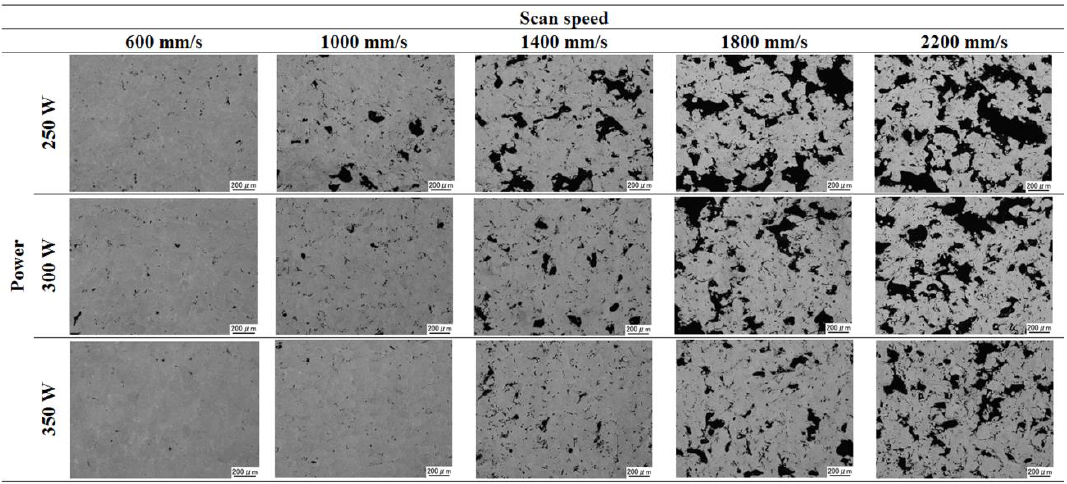
Figure 3. Optical microscope (OM) images of vertical cross sections of C/Al SLM composites with changing the laser scan conditions of laser power and scan speed.